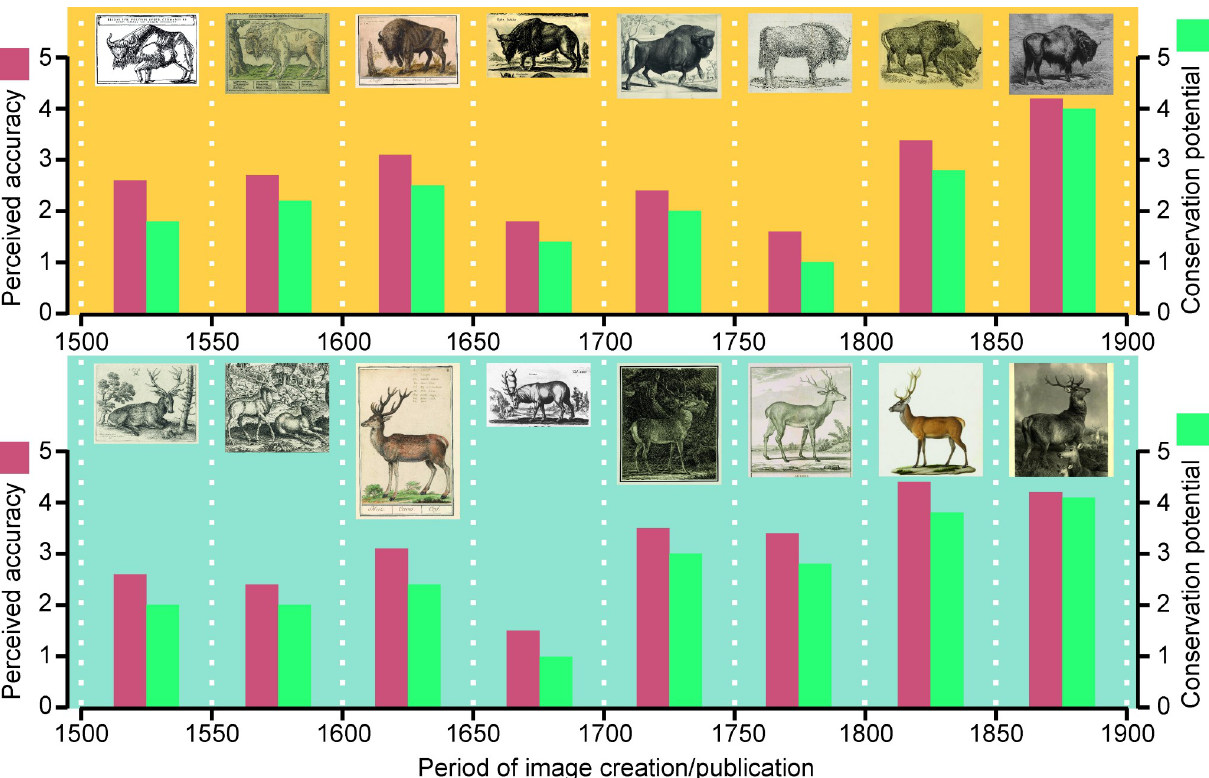
Fig 2. Evaluation of modern perception of anatomical accuracy and conservation potential of historical depictions of European bison (above) and red deer (below).